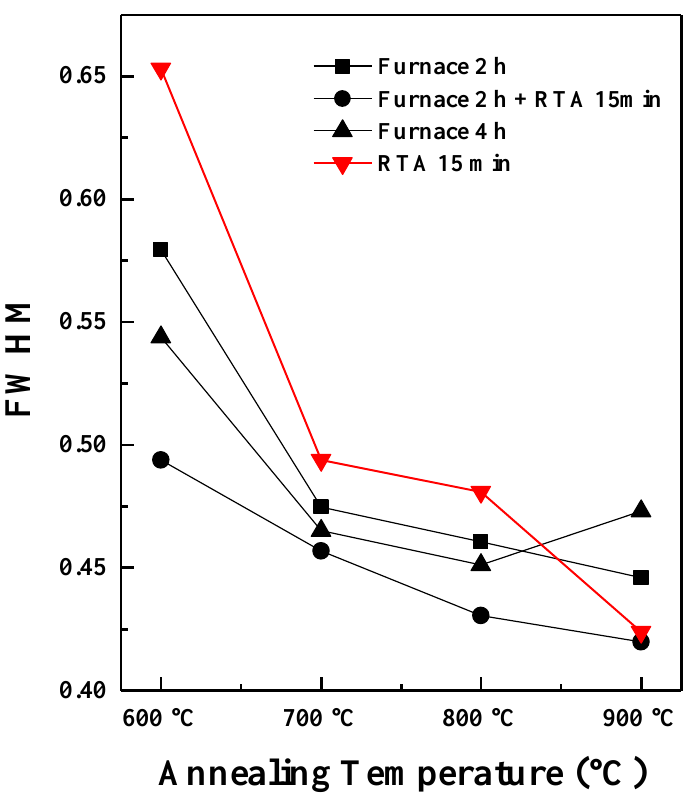
Figure 5. Results of FWHM and grain size by various annealing processes and temperatures.